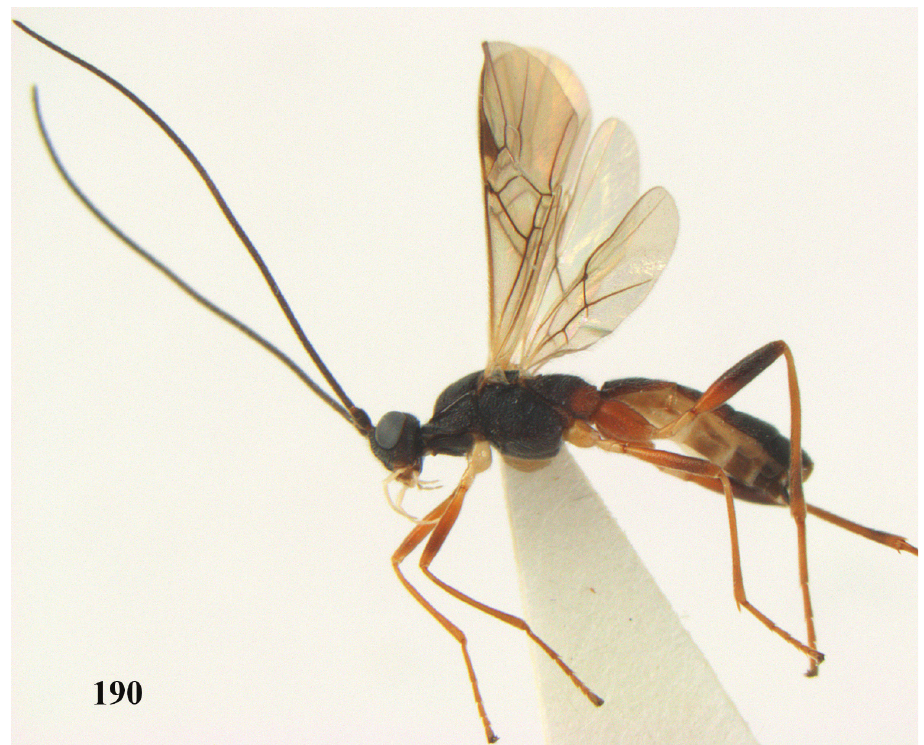
Figure 190. Aleiodes jakowlewi (Kokujev), ♀ , Finland, Kangaslampi, habitus